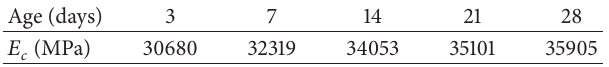
Table 3: Elastic modulus of the concrete at different